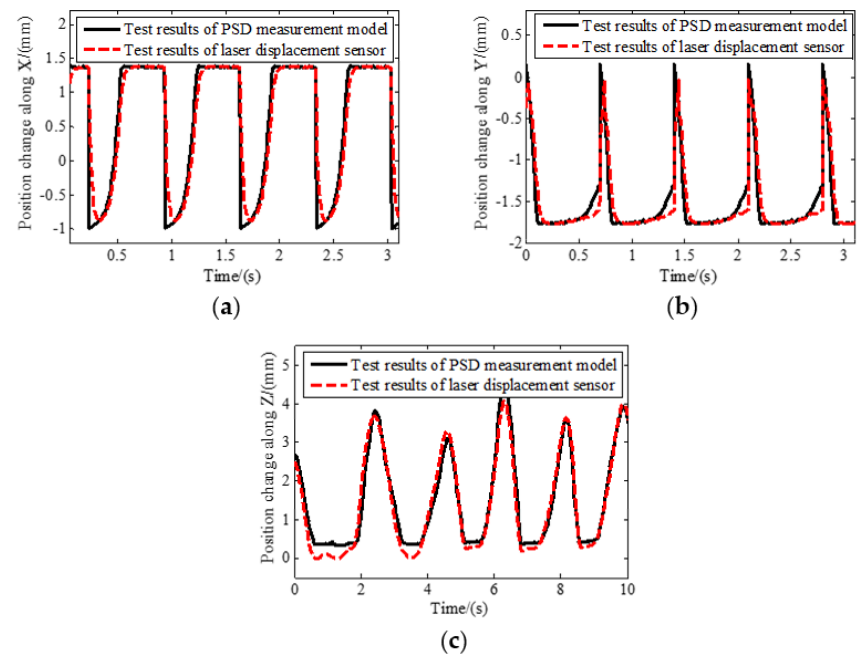
Figure 8. Comparison of relative position changes: ( a ) Position change along X direction; ( b ) position change along Y direction; ( c ) position change along Z direction.